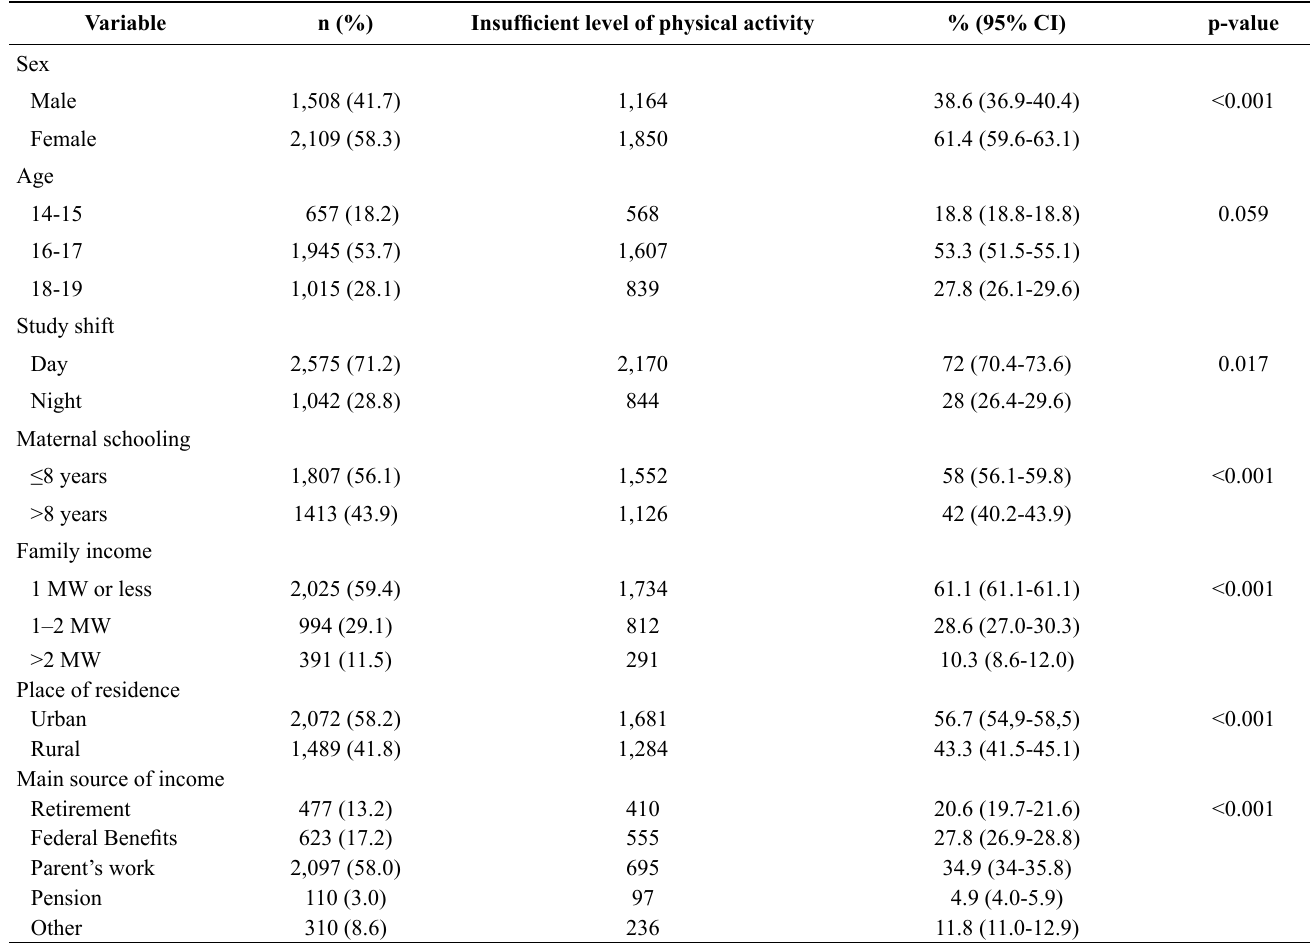
Table 1. Characteristics of the sample ( n =3,617), Sergipe, Brazil, 2016.